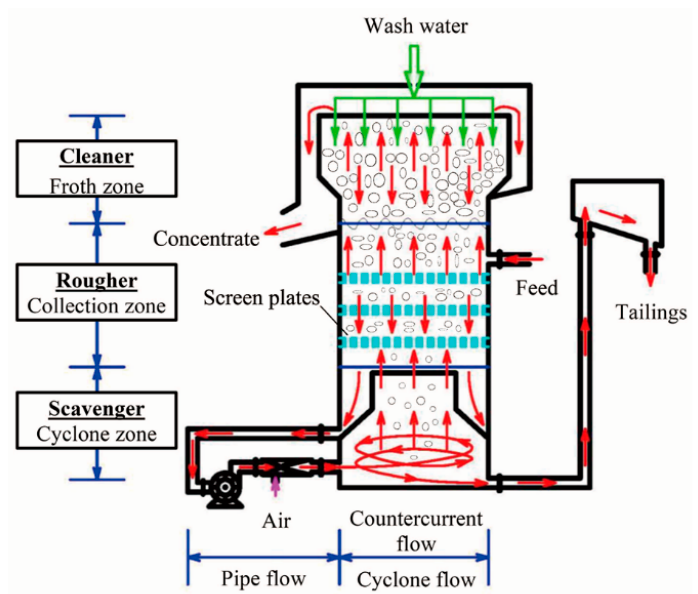
Figure 2. Schematic illustration of the flotation column.